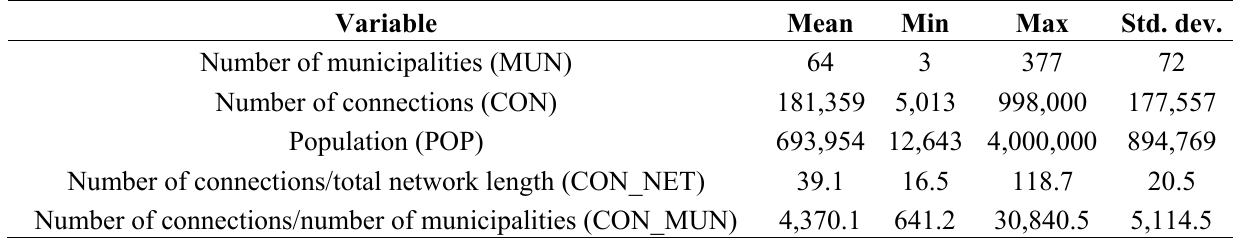
Table 4. Descriptive statistics of environmental (continuous) factors.